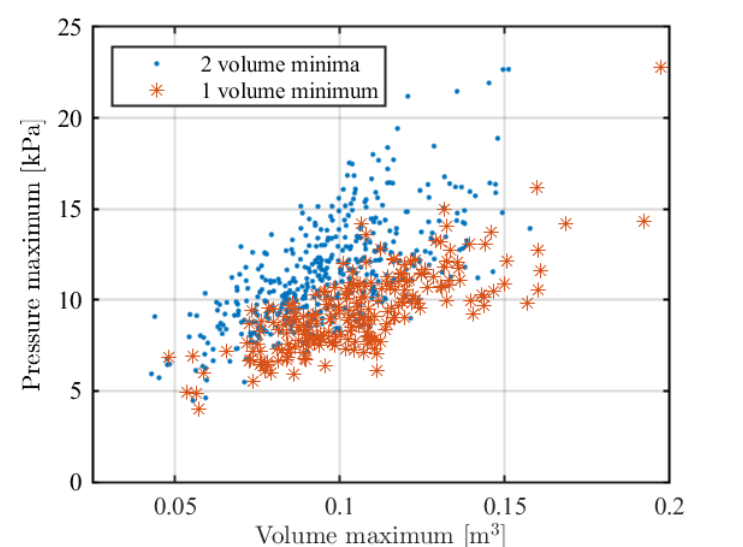
Figure 5. Maximum values of volume and pressure within each blade passage of group B at 96.5 rpm distinguished by the number of volume